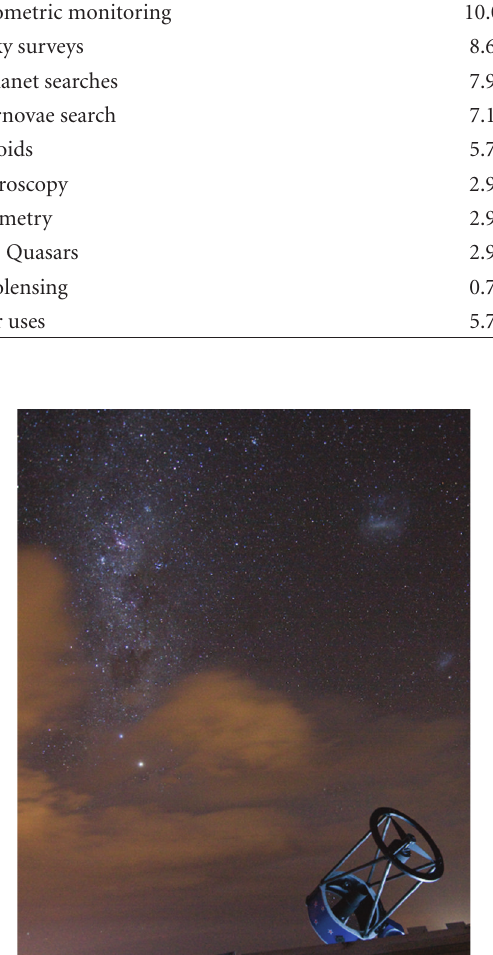
Figure 10: The Yock-Allen 0.6m Robotic Telescope at the BOOTES-3 astronomical station in Blenheim (New Zealand) with the Alpha and Beta Centauri, the Southern Cross, and Magellanic Clouds in the background. Photo courtesy of Dietzel.